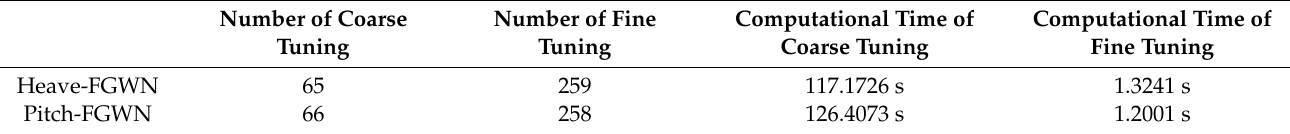
Table 7. Computational time with simulation data.